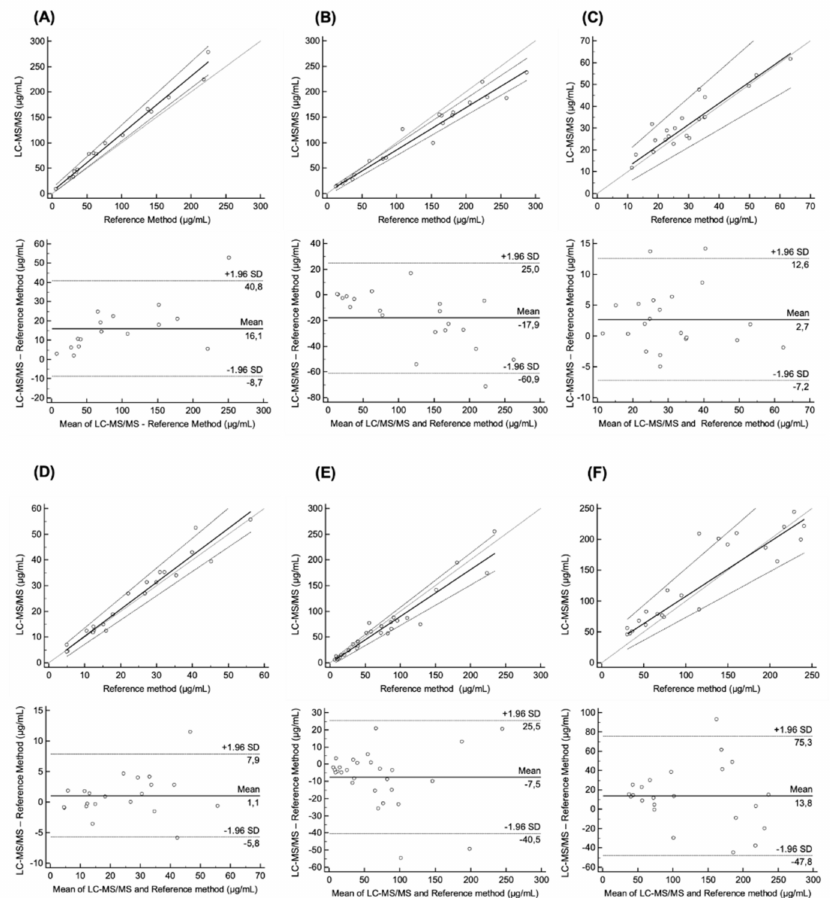
Figure 4. Passing-Bablok and Bland–Altman plots: Passing-Bablok regression plot of concentrations measured by LC–MS/MS and reference method for ( A ) bevacizumab ( n = 16), ( B ) cetuximab ( n = 21), ( C ) nivolumab ( n = 21), ( D ) pembrolizumab ( n = 21), ( E ) rituximab ( n = 28), ( F ) trastuzumab ( n = 23) in patients with advanced cancers. Bland–Altman analysis of the difference between LC–MS/MS and reference method for ( A ) bevacizumab, ( B ) cetuximab, ( C ) nivolumab, ( D ) pembrolizumab, ( E ) rituximab, ( F ) trastuzumab. The mean ± 1.96 standard deviation lines (95% limits of agreement) are plotted for